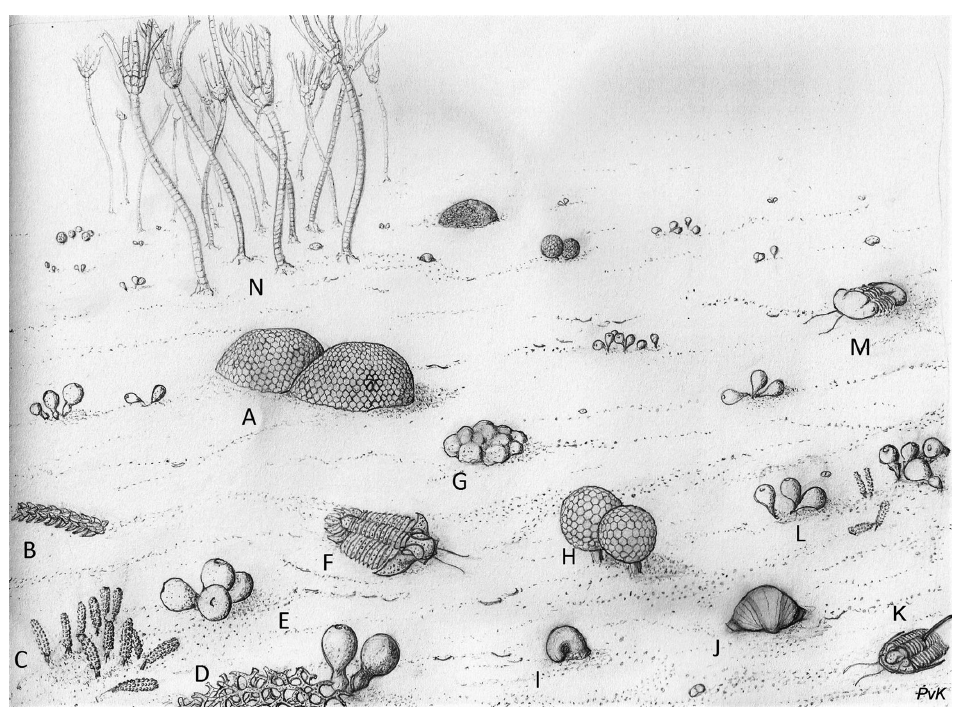
Fig. 15. Impression of the Middle–Late Sandbian marine community as represented by species characteristic of the type 1 fossil assemblage. A, Mastopora concava ; B, Plumulites sp.; C, Hoeegonites kringla ; D, Vermiporella fragilis ; E, Apidium sp. [‘claviformis’]; F, Otarozoum peri ; G, Solenopora spongioides ; H, Coelosphaeridium sphaericum ; I, Cymbularia compressa ; J, Bilobia aff. musca ; K, Harpidella planifrons ; L, Apidium pygmaeum ; M, Illaenus jewensis ; N, crinoids.